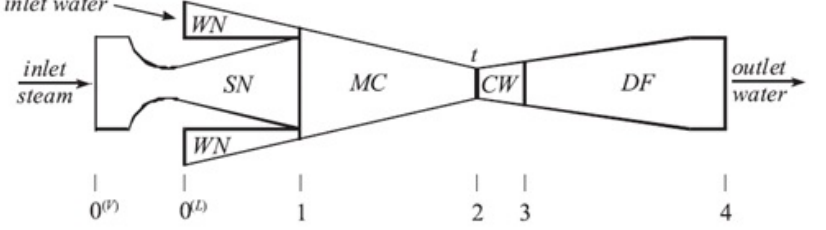
Figure 23. Schematic view of the steam injector SN—steam nozzle, WN—water nozzle, MC—mixing chamber, DF—diffuser, t—mixing chamber throat, CW—condensation wave [85].